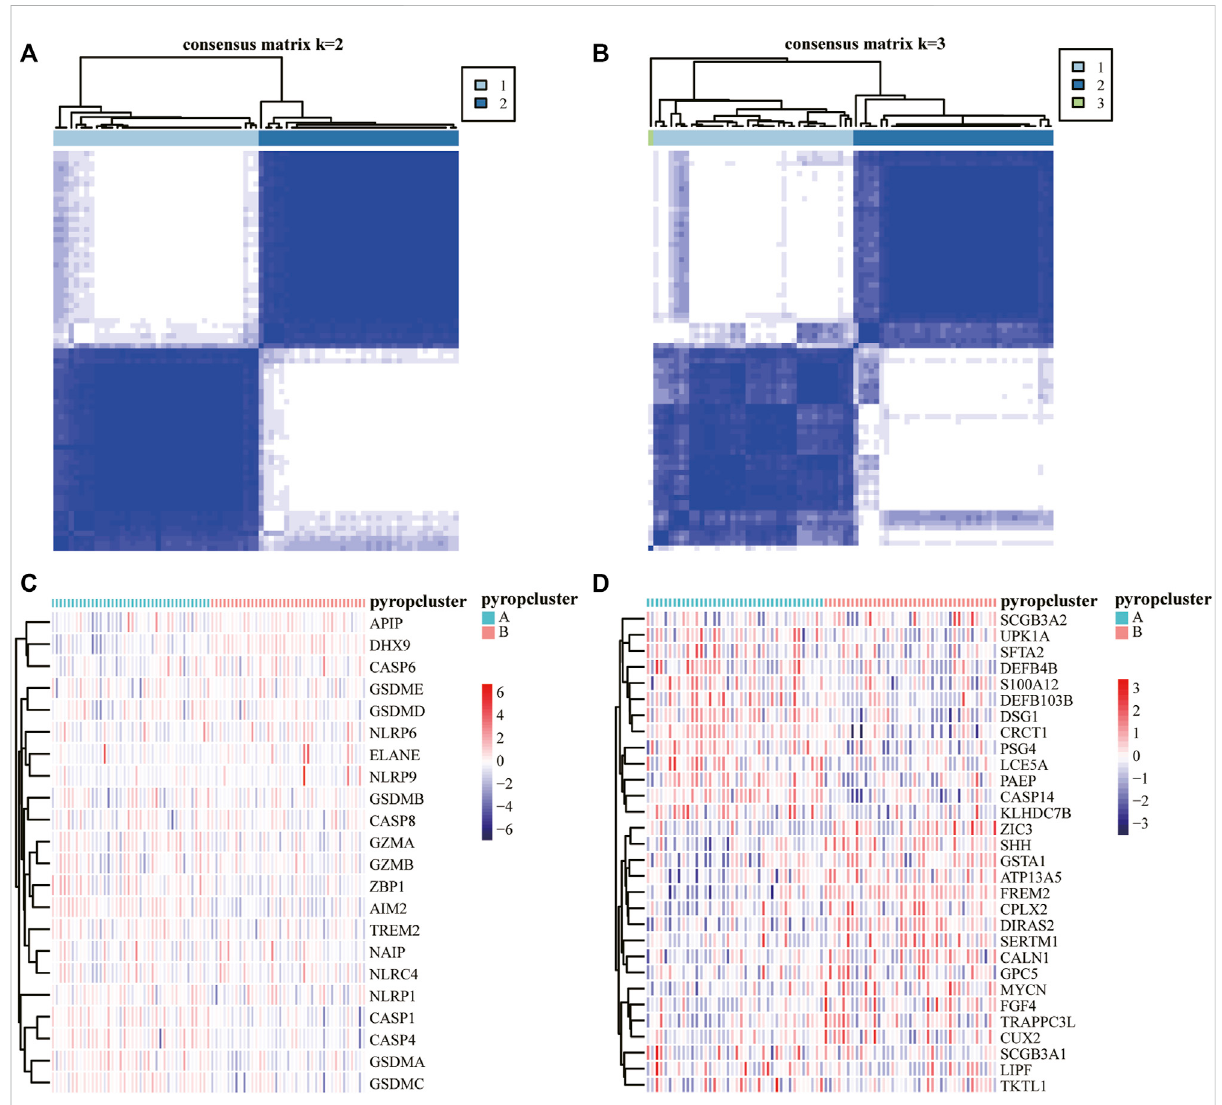
FIGURE 3 Analysis of pyroptosis subtypes. (A,B) Cluster analysis of TCGA-ESCC samples and k = 2 was the most appropriate. (C) Expression heatmap of 22 pyroptosis genes in different pyroptosis subtypes. (D) Expression heatmap of part of the DEGs between pyroptosis subtypes, red indicates upregulated, blue indicates